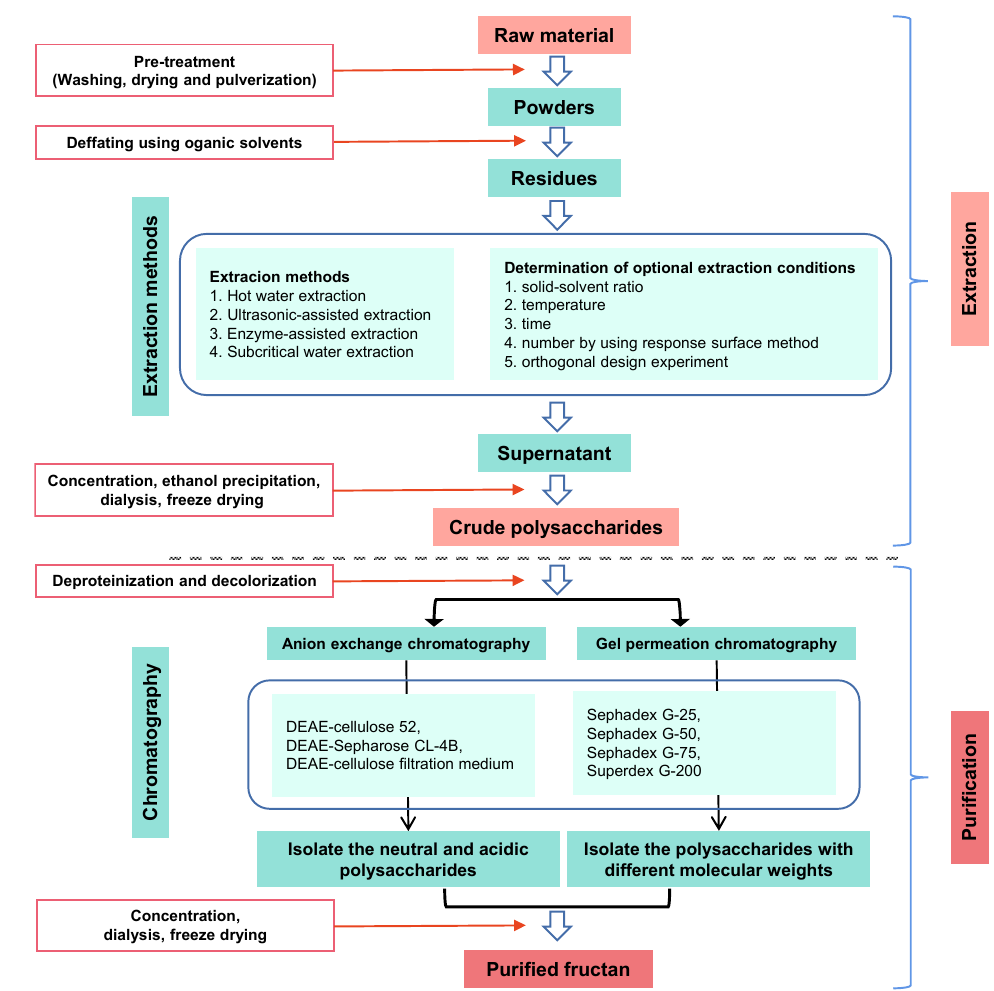
Figure 2. Schematic diagram of extraction and purification of fructans.